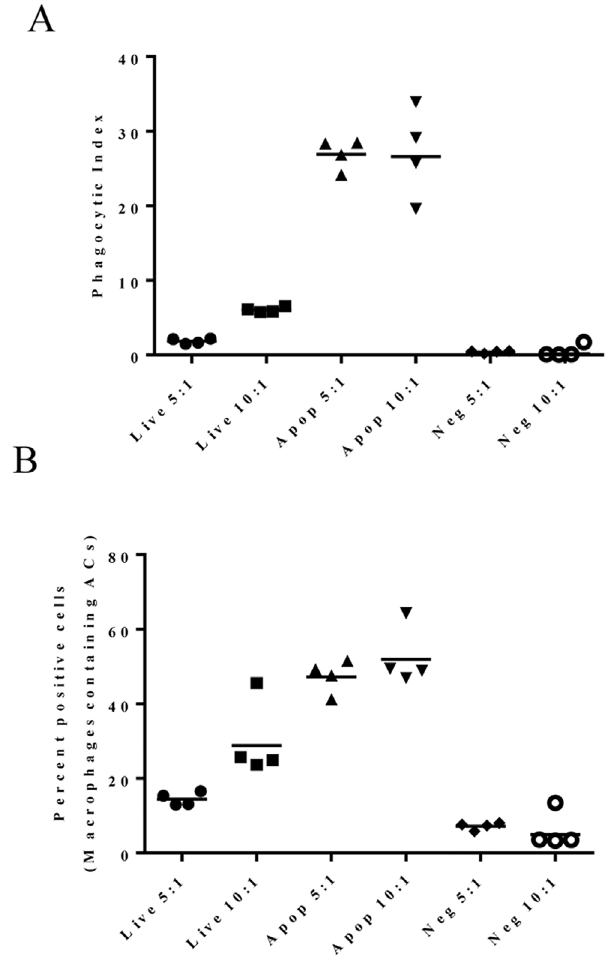
Fig 4. Phagocytic Index (PI) provides a direct measure of macrophage function. Comparison of data presented as either PI (A) or representing the frequency of macrophages containing apoptotic cells expressed as “ percent (%) positive cells ” (B) within the same population in each well of a 96 well plate. The PI was calculated as described in Fig 3. Calculation of the % positive cells is based on the assumption that macrophages (APC + ) containing apoptotic cells (Cy3 + ) appear fluorescent for both fluorophores and calculated as follows: % positive cells = (# APC + Cy3 + cells / # APC + cells) * 100. Ratios listed along the X- axis represent the (Target) T: M Φ ratios. Baseline engulfment was determined using M Φ ’ s co-cultured with live cells (Live); Negative controls consisted of cytochalasin D treated M Φ ’ s co-cultured with apoptotic cells (Neg). Test samples consisted of apoptotic cells co-cultured with M Φ ’ s